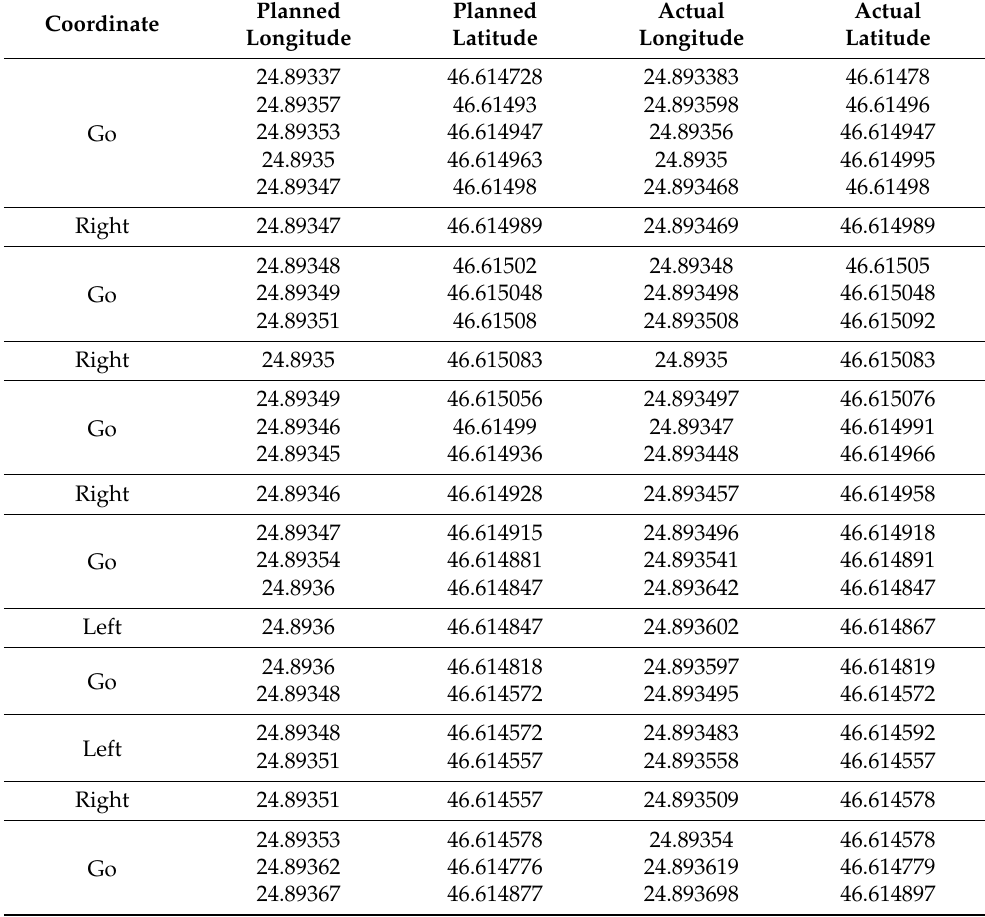
Table 8. Navigation planned path compared with the actual path (outdoor